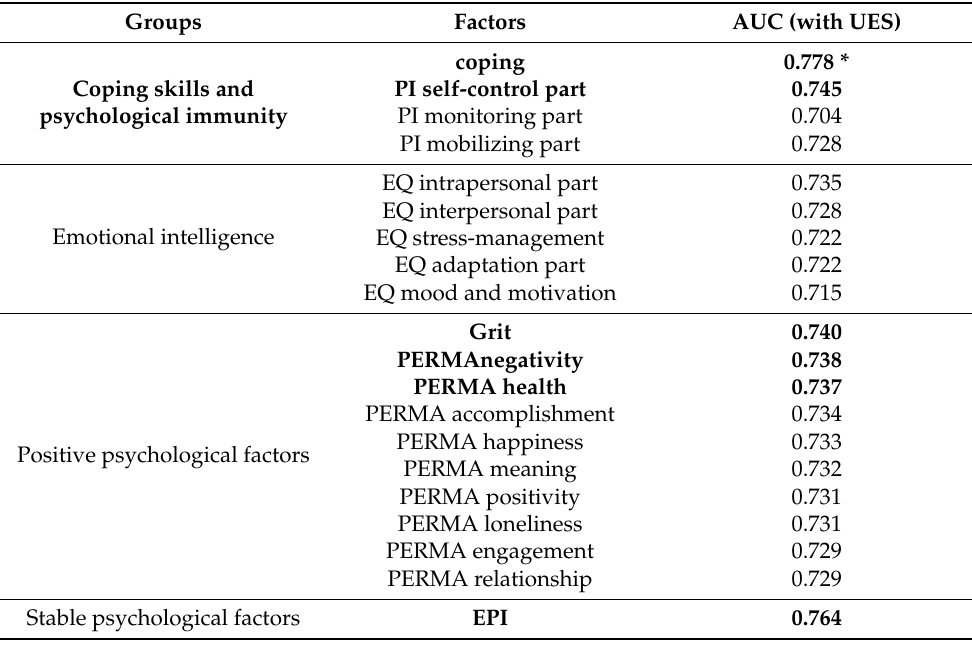
Table 2. The predictive power (area under the curve (AUC) values) of psychological factors combined with the university entrance score. The AUC of the university entrance score (UES) alone was 0.737; the other AUC values should be interpreted in comparison with this value.). *: p <